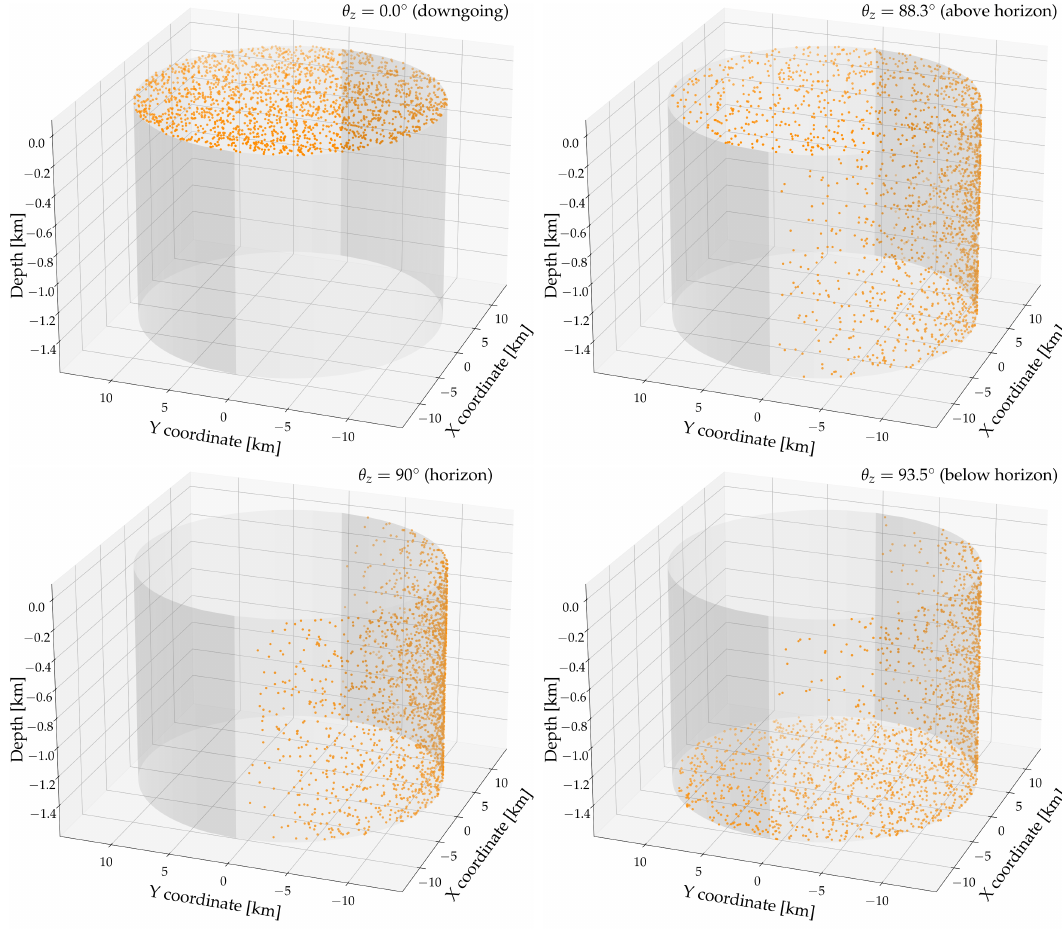
Figure 7 . Distribution of neutrinos hitting on simulated IceCube-Gen2 detector volume, from four illustrative directions. See the main text for details. For this figure only, neutrinos are not attenuated while propagating inside the